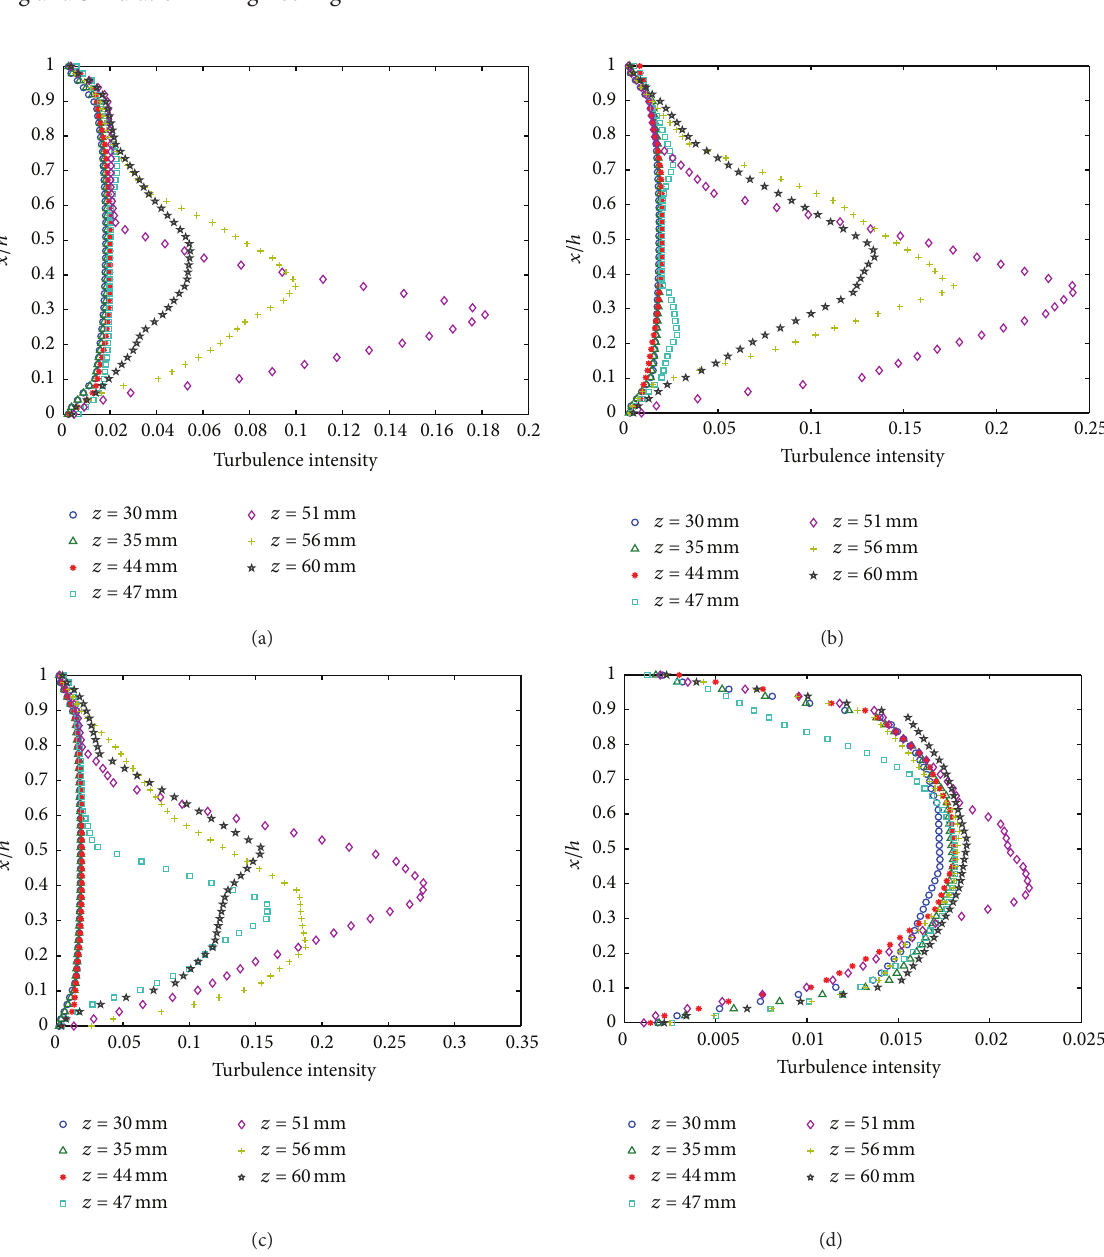
Figure 10: Turbulence intensity plotted against wall-normal distance scaled by lumen height ( ℎ ) at different axial positions along the length of the artery during peak systole ( 𝑄 max ) for (a) Type I, (b) Type II, (c) Type III, and (d) Type